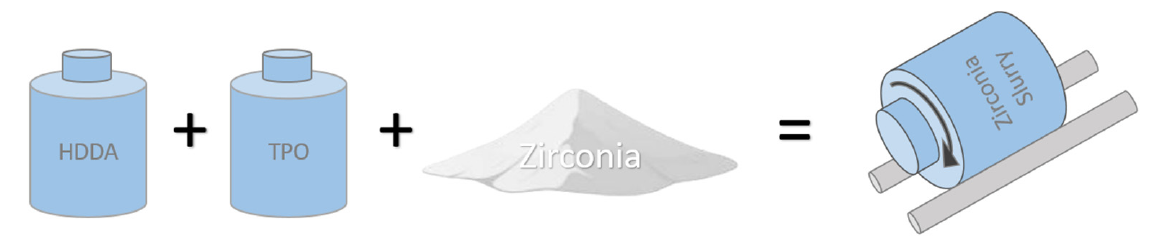
Figure 3. Preparation of making zirconia slurry.